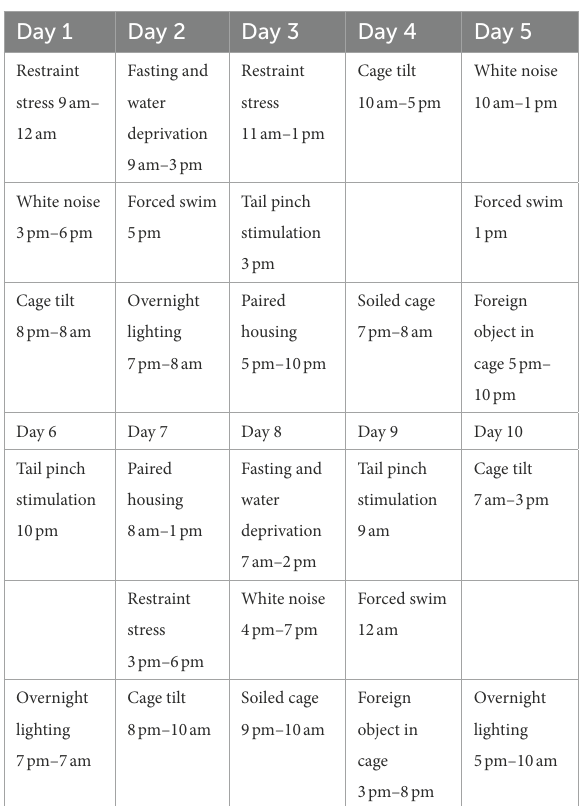
TABLE 1 The procedure of chronic unpredictable mild stress in pregnant mice during gestational day 7 (G7) to 16